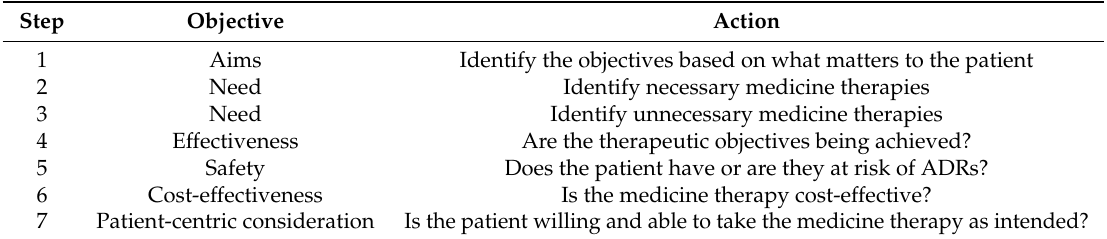
Table 2. Seven-step plan for polypharmacy medicine review as detailed in the SIMPATHY